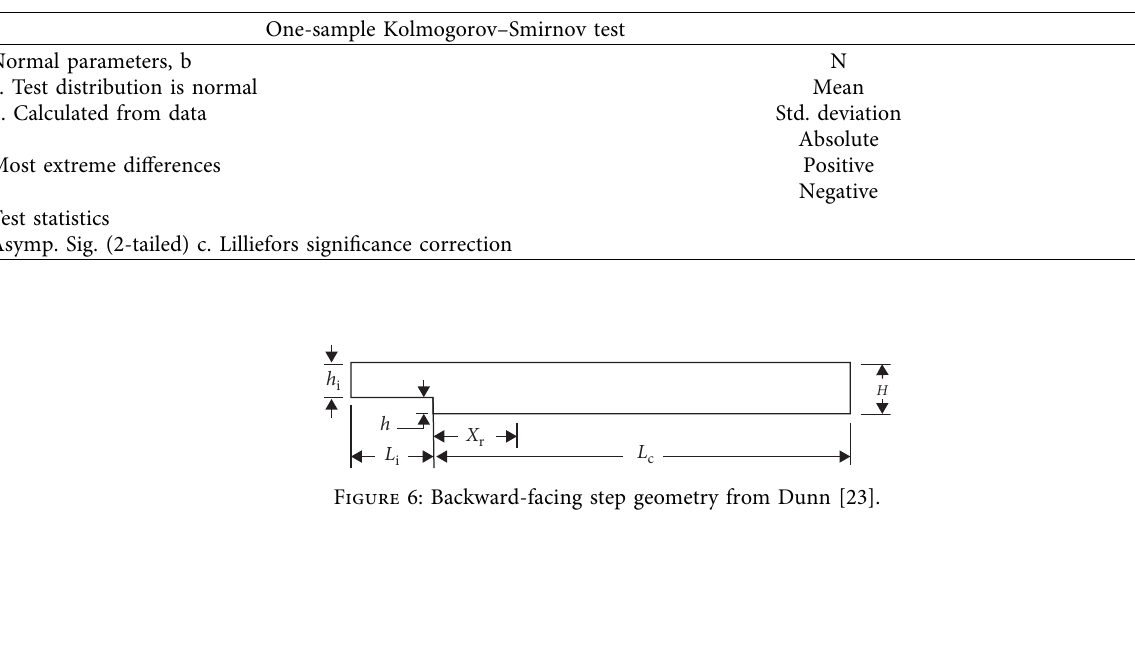
Figure 5: Scatter diagrams of Nu and C Table 3: K – S test results of Xr .